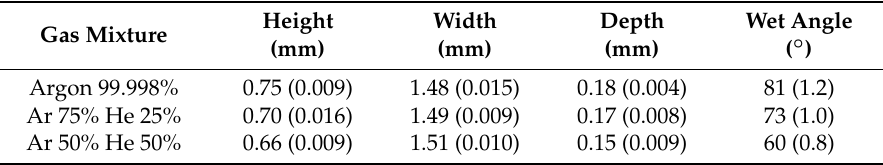
Table 8. Summary of results for experimental tests at 600 W.